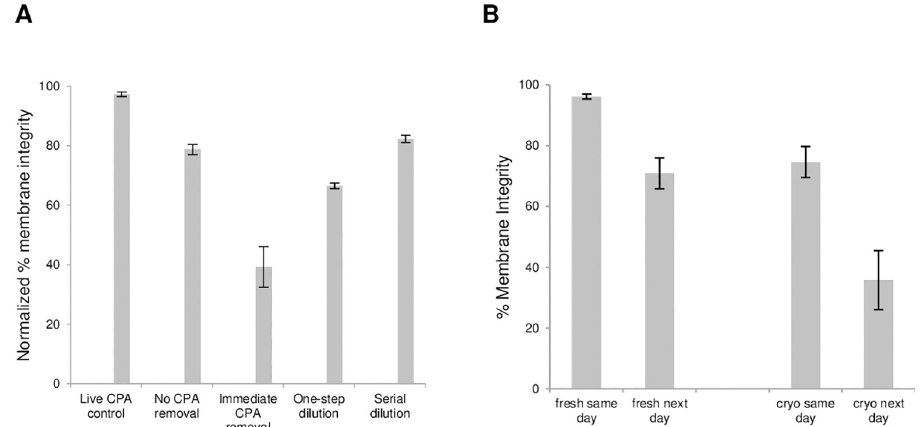
Fig 2. Effects of cryoprotectant removal (A) and extended incubation (B) on membrane integrity of dispersed islet cells. Islets were dispersed as described in the Materials and Methods and cooled at 1˚C/min to –40˚C in the presence of 10% DMSO and 6% HES, then stored in liquid nitrogen. Cells were thawed rapidly in a 37˚C water bath. (A) Membrane integrity was assessed with a) no cryoprotectant (CPA) removal, b) immediate CPA removal, c) one-step dilution, and d) serial dilution, as described in the Materials and Methods. Fresh cells were used as positive control, and membrane integrity values were normalized against fresh cells in the absence of cryoprotectants. (B) For each donor sample, fresh and cryopreserved cells were assessed for membrane integrity on the same day or after overnight incubation in medium at 37˚C and 5% CO 2 . Data points for both (A) and (B) are the average of three independent experiments and error bars represent standard error of the mean (S1